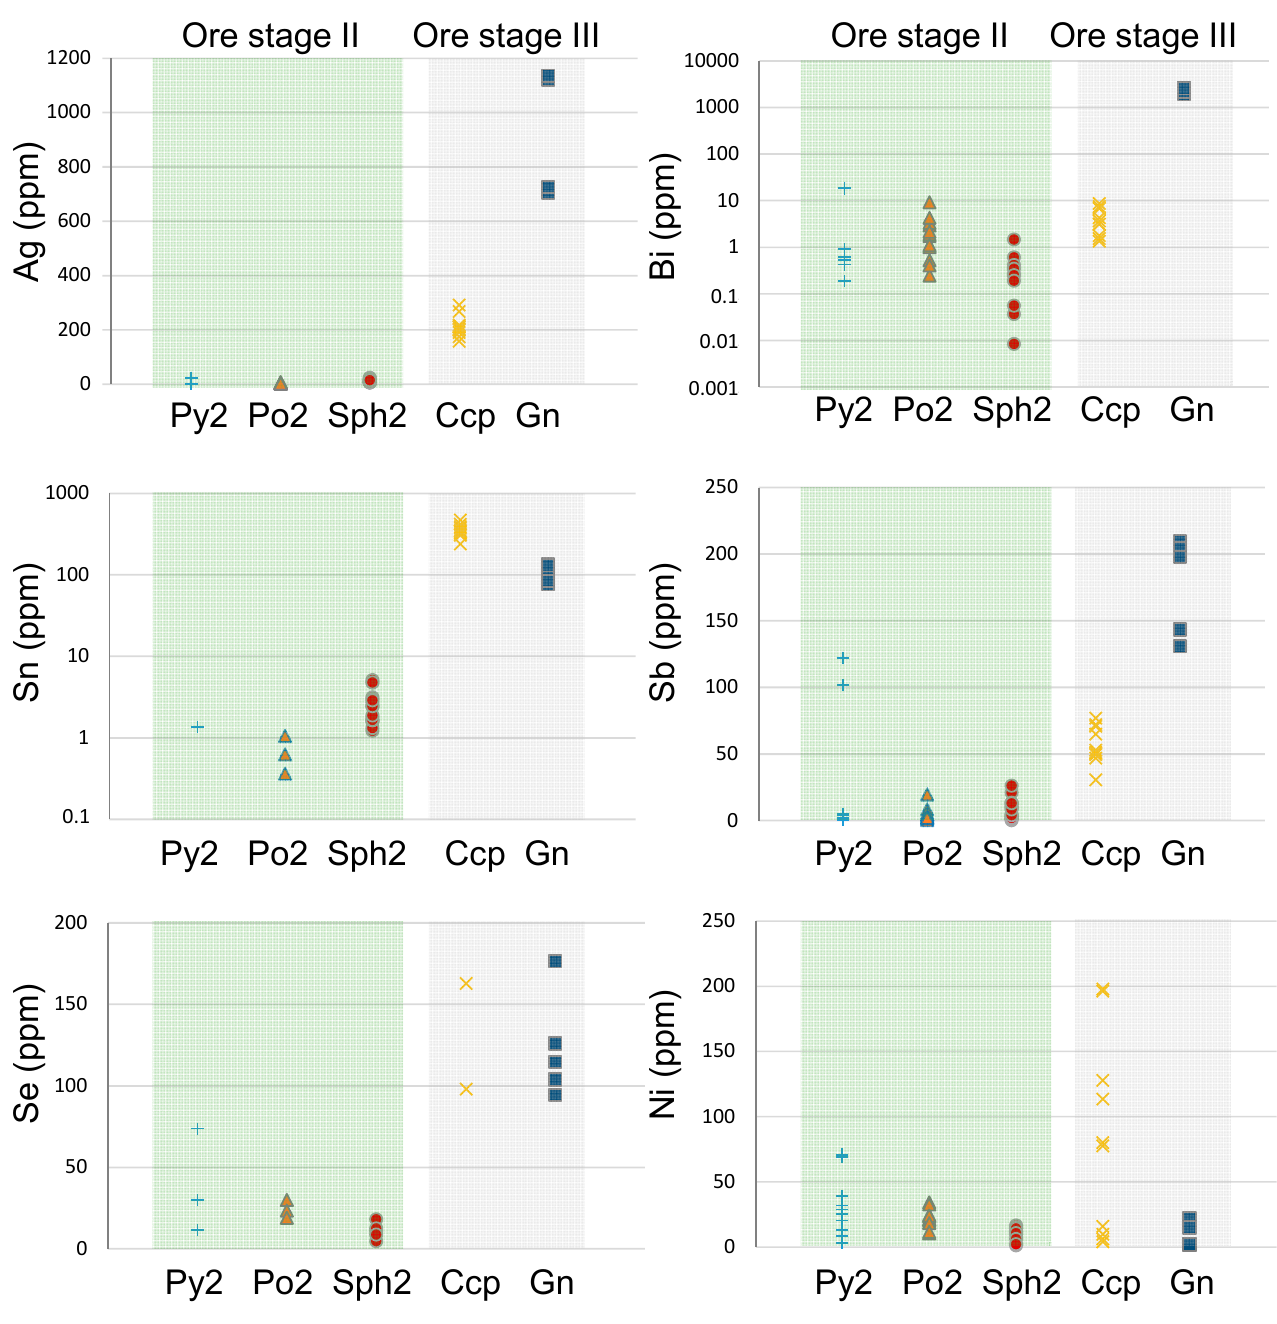
Figure 7. Distribution of main trace elements in major vein sulfides in the Koudiat Aïcha deposit (stages II and III). Py2: pyrite 2, Po2: pyrrhotite 2, Sph2: sphalerite 2, Ccp: chalcopyrite, Gn: galena.